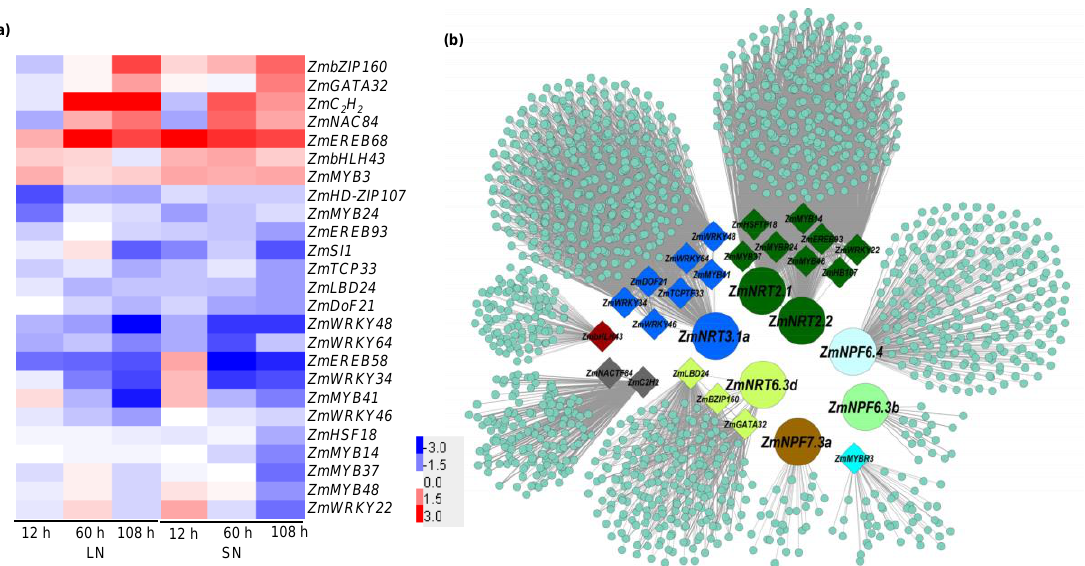
Figure 8. GAs regulated the expression of transcription factors in maize responded to NO 3 − supply. ( a ) Heatmap showing the significant expression of transcription factors in the 2-kb putative promoter region of nitrate transporter genes. Different expression levels were shown as log 2 FC, blue for downregulation and red for upregulation, as shown in the color bar. ( b ) Weighted gene co-expression network analysis (WGCNA) of DEGs.